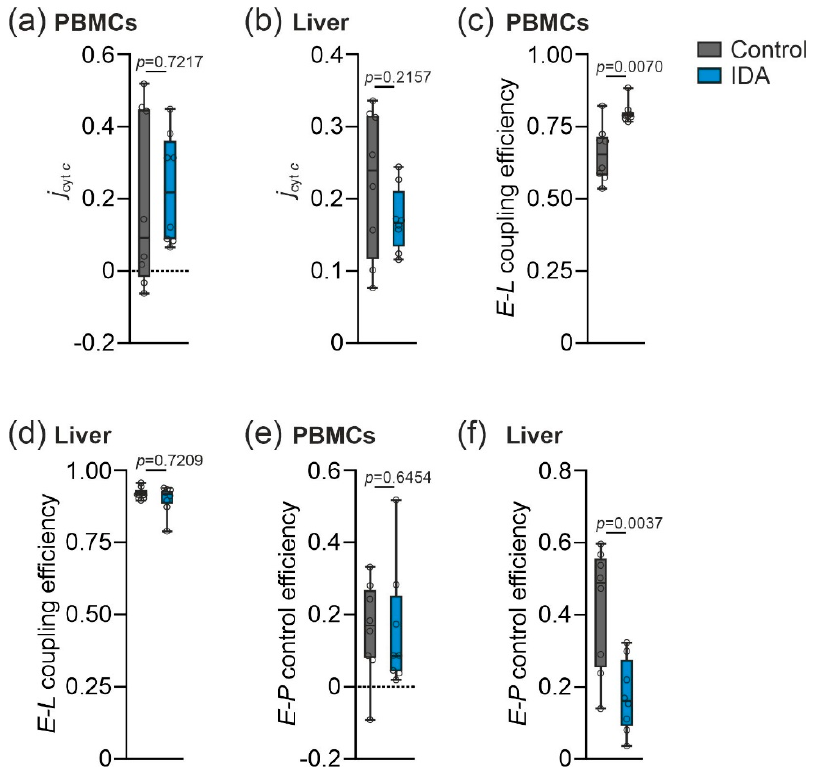
Figure 4. Effects of IDA on flux control efficiencies in rat PBMCs and liver. ( a , b ) Cytochrome c control efficiency ( j cyt c ) indicates integrity of the outer mitochondrial membrane. ( c , d ) E-L coupling efficiency ( j E-L ) indicates preserved coupling of electron transfer to phosphorylation of ADP. ( e , f ) E-P control efficiency indicates the limitation of the OXPHOS capacity due to the capacity of the phosphorylation system. N = 8 rats per group. An unpaired two-tailed Student’s t -test was applied for all normal distributed results; a Mann-Whitney U-test was applied for the nonparametric results shown in ( c – e ). Values are shown as median ± interquartile range. p -Values are shown in the graphs.